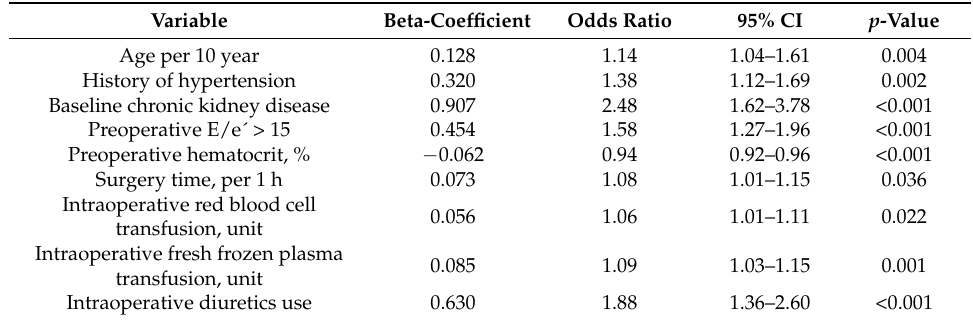
Table 3. Development of multivariable logistic regression model to predict acute kidney injury using stepwise variable selection.